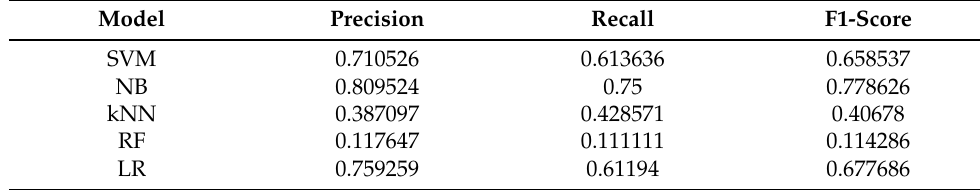
Table 5. Performance of ML models (deletion).